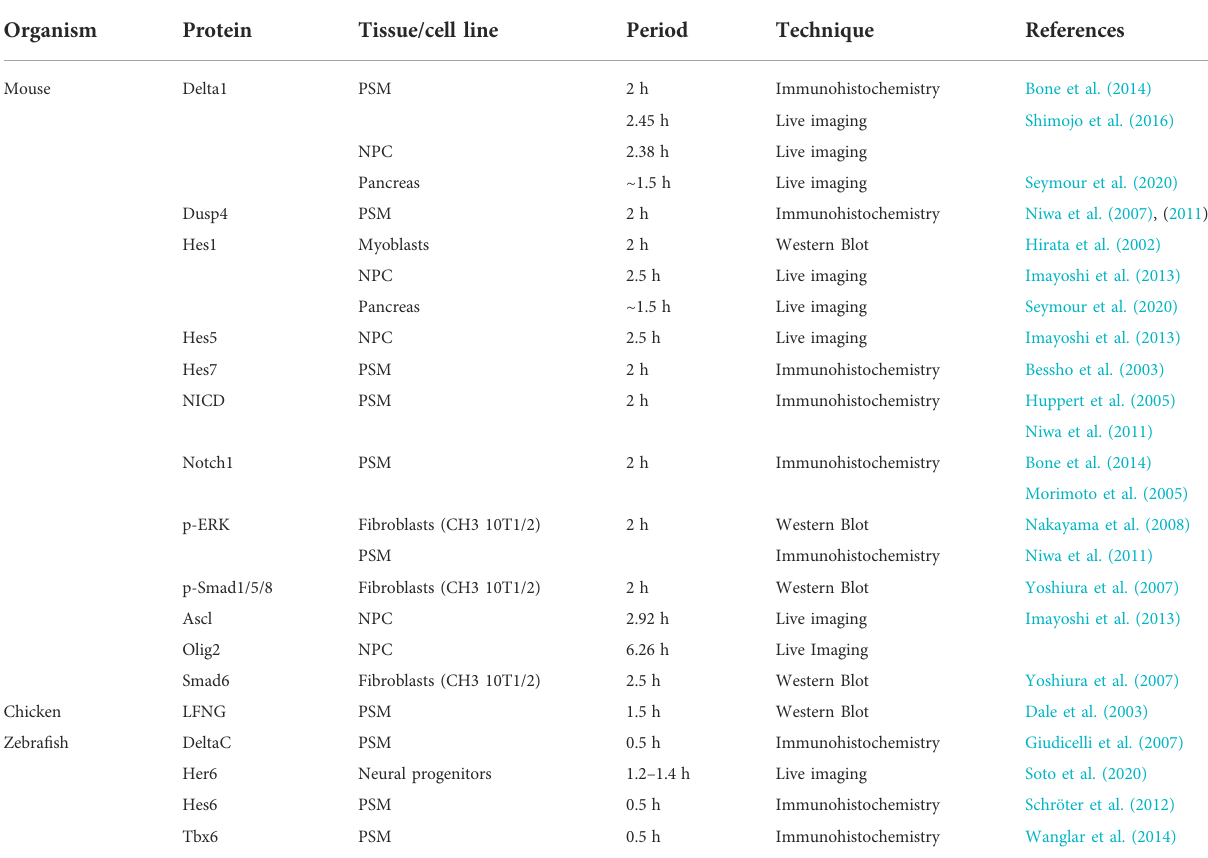
TABLE 3 Periodicity of cyclic protein